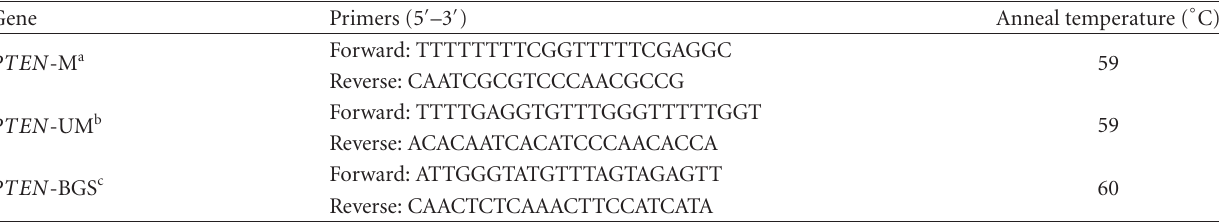
Table 2: Primers sequences for MSP and bisulfite sequencing analysis.